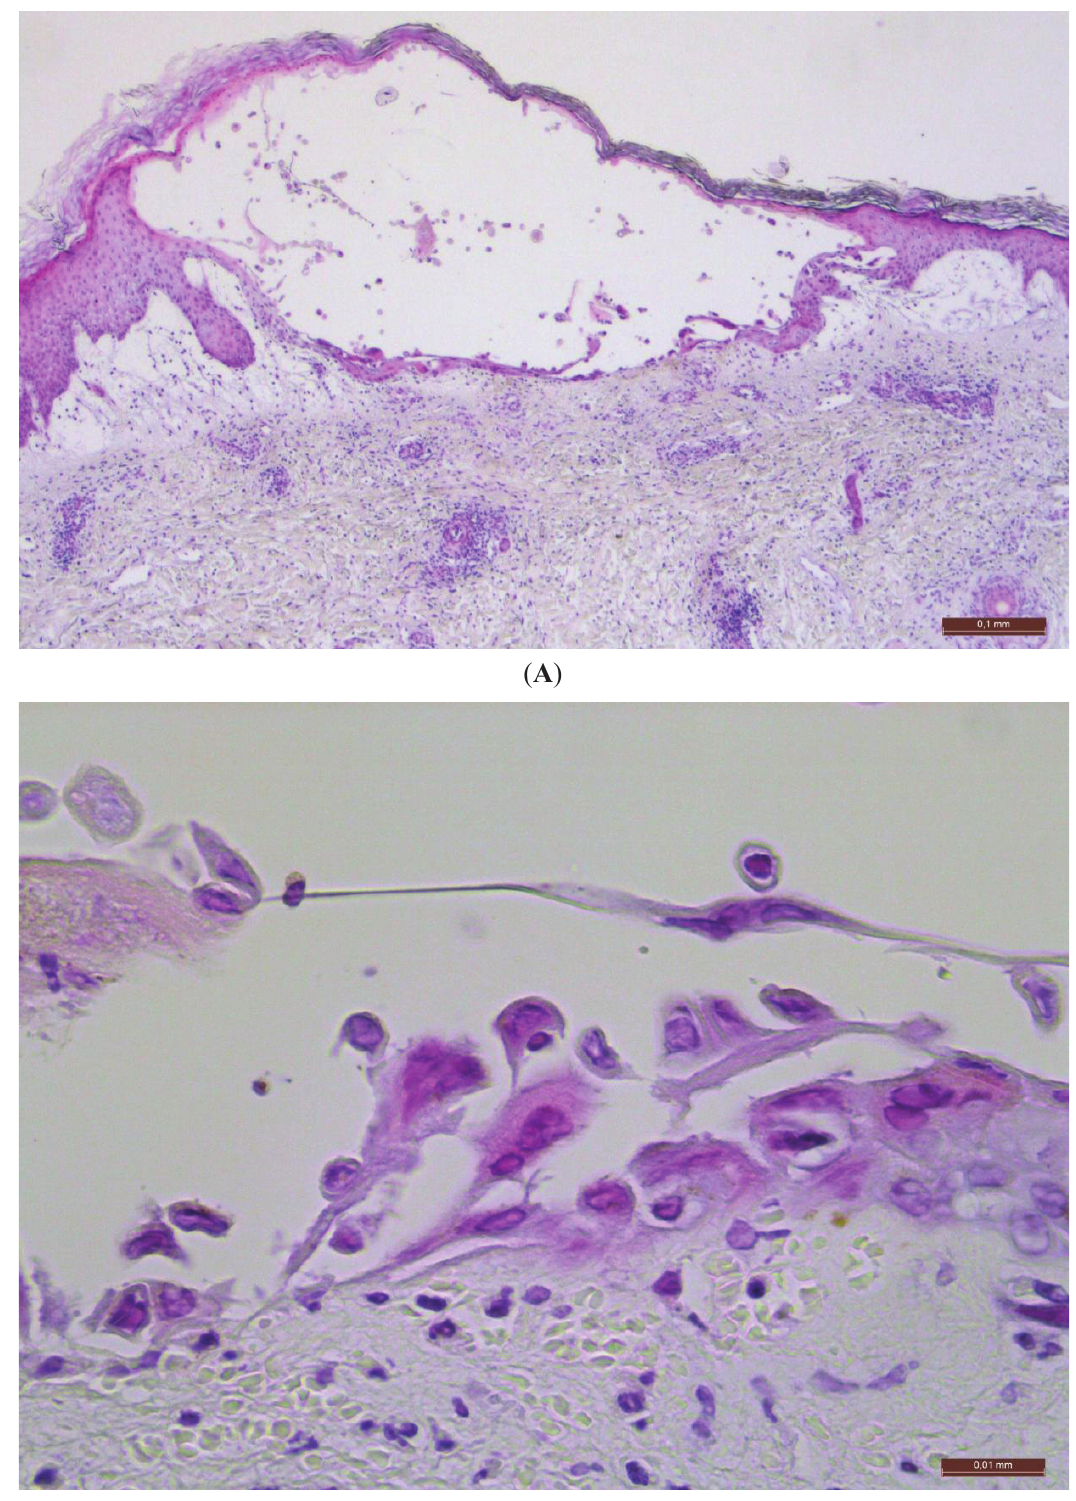
Figure 2. Histopathological examination. ( A ) Intraepidermal bulla (H&E, ×40). Scale bar = 0.1 mm. ( B ) Ballooning degeneration of keratinocytes and giant multinucleated (H&E, ×400). Scale bar = 0.01